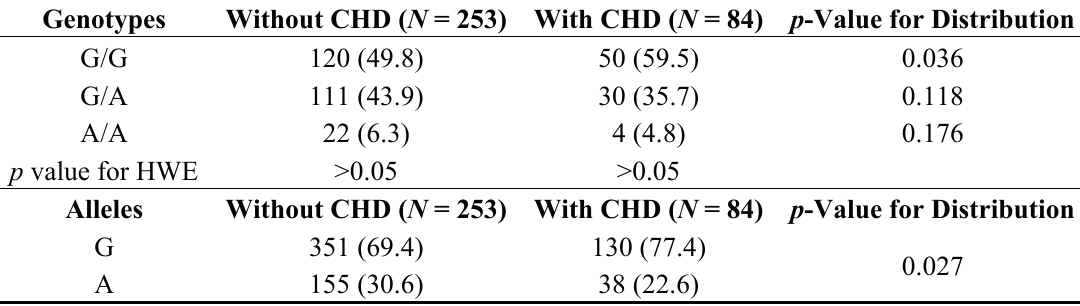
Table 2. Distributions of genotypes and alleles in the case and control